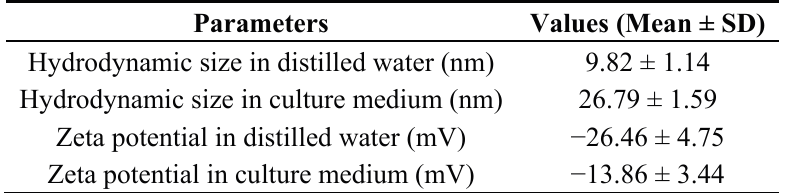
Table 1. Physicochemical characteristics of cadmium telluride quantum dots (CdTe